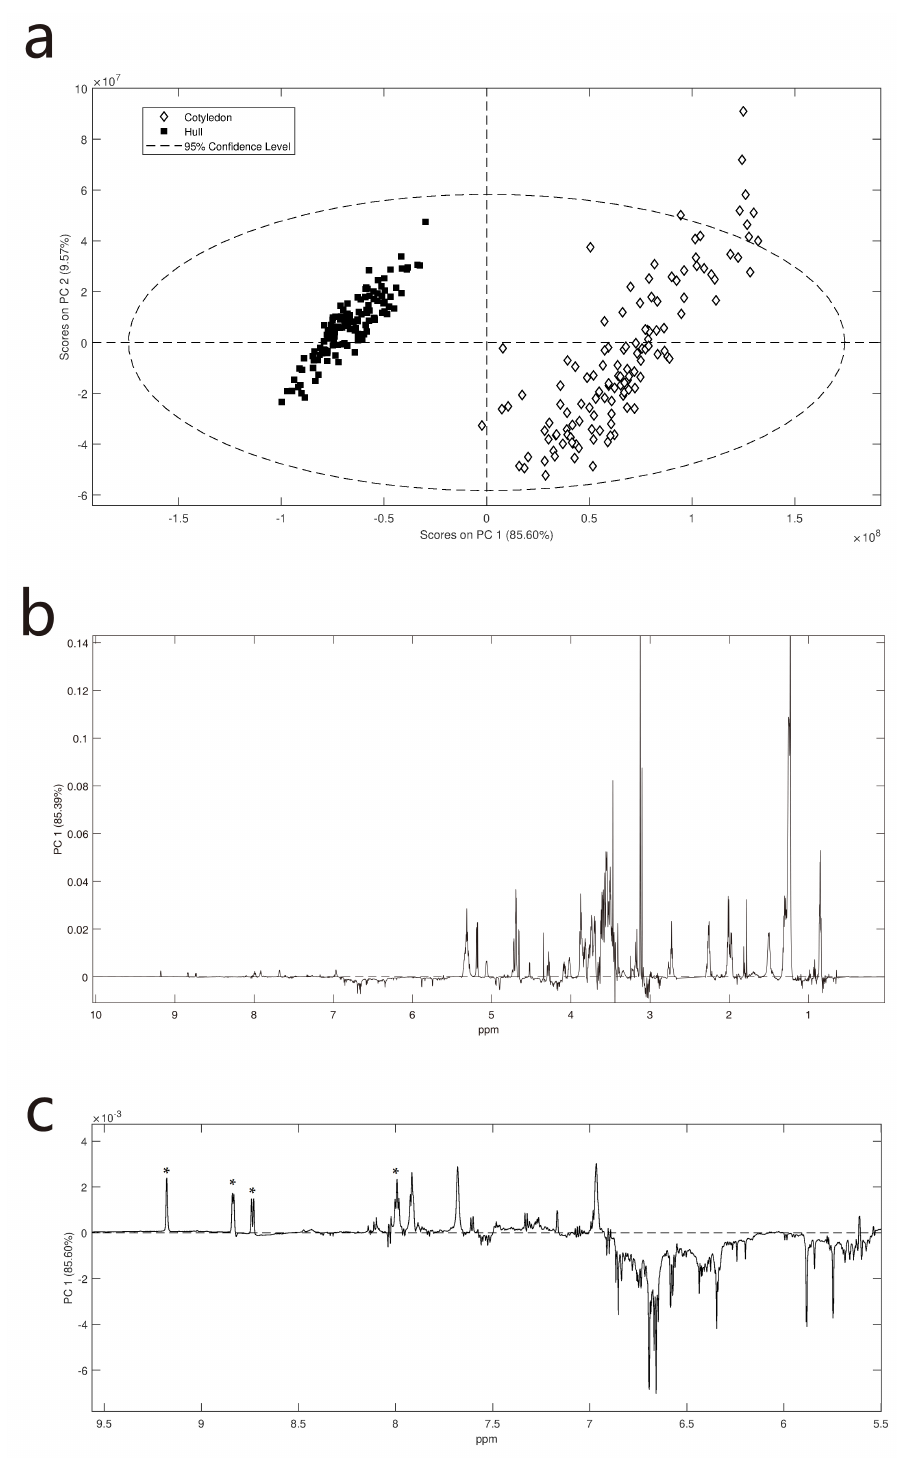
Figure 1. PCA scores and loading plots for 1 H NMR data of lentil hulls and cotyledon: ( a ) PCA scores plot showing clear separation of hulls and cotyledons regardless of genotype or site; ( b ) loading plot of PC1 variables indicates that the cotyledon has more lipids and carbohydrates; ( c ) expansion of the loading plot focusing on the aromatic region of the spectrum. Downfield signals (above 8.5 ppm) are relatively elevated in cotyledons. Magnetic resonances due to phenolic-containing metabolites (from 5.5 to 8 ppm) are elevated in hulls. Trigonelline resonances indicated by